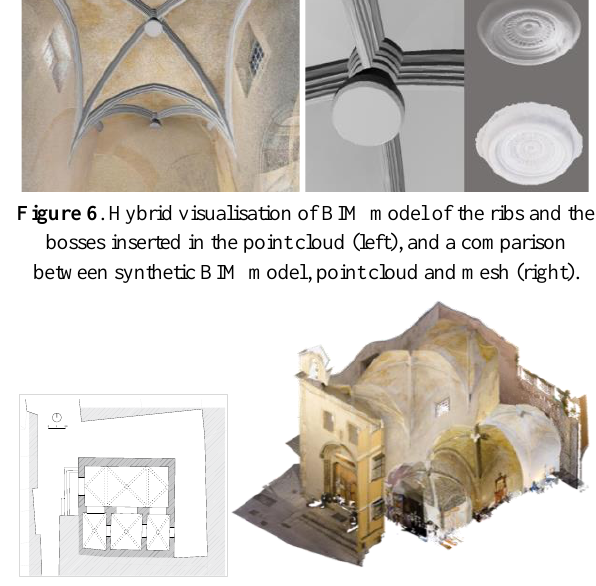
Figure 7 . Site plan (left) and 3D point cloud